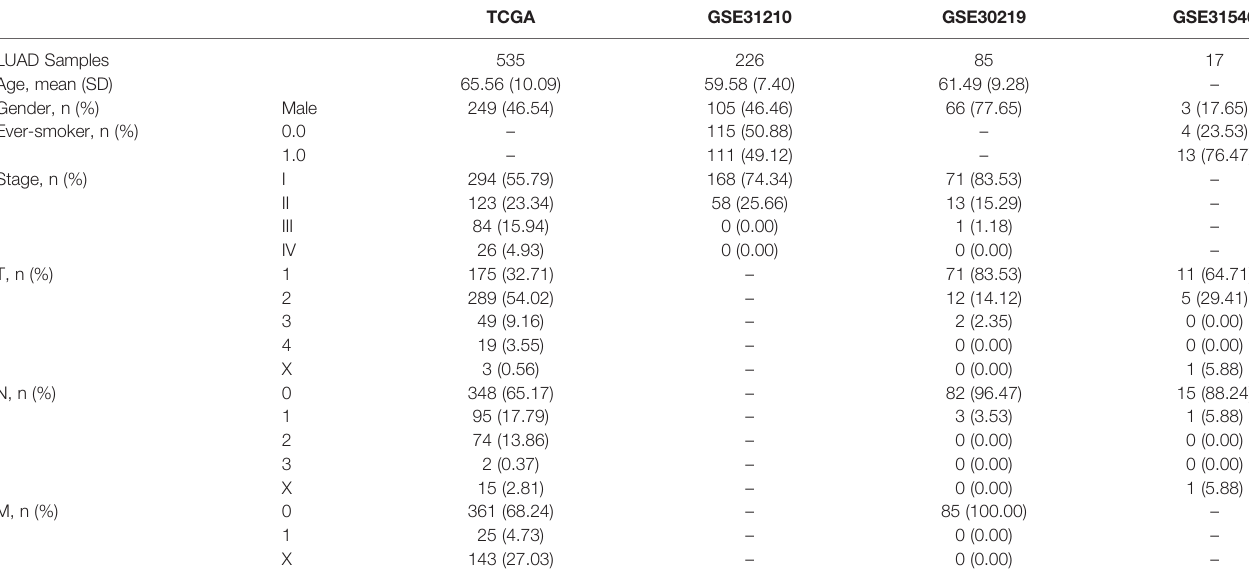
TABLE 1 | The baseline characteristics of the patients in TCGA and GEO